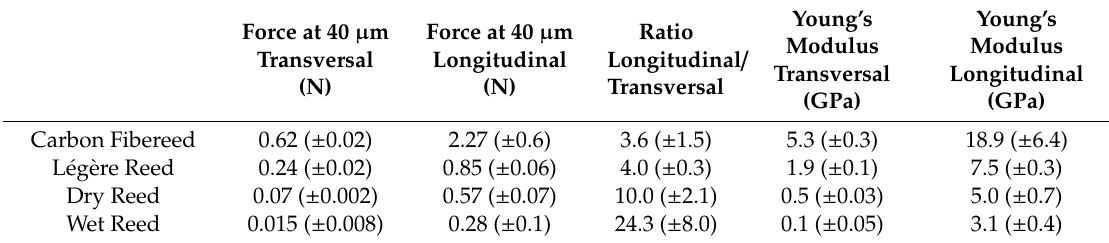
Table 2. Summary of the measured force and moduli of elasticity for the different reed materials.